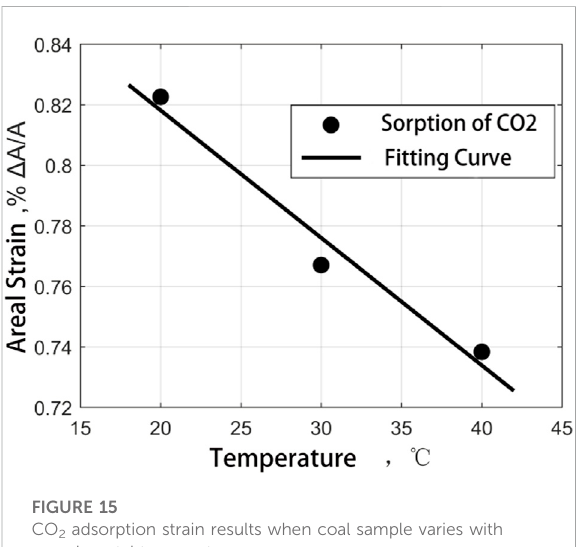
FIGURE 15 CO 2 adsorption strain results when coal sample varies with experimental temperature.